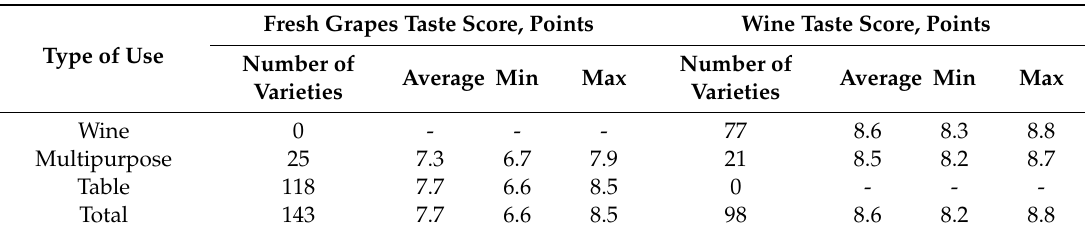
Table 1. Variability of test scores in groups of grape varieties of different types of use.